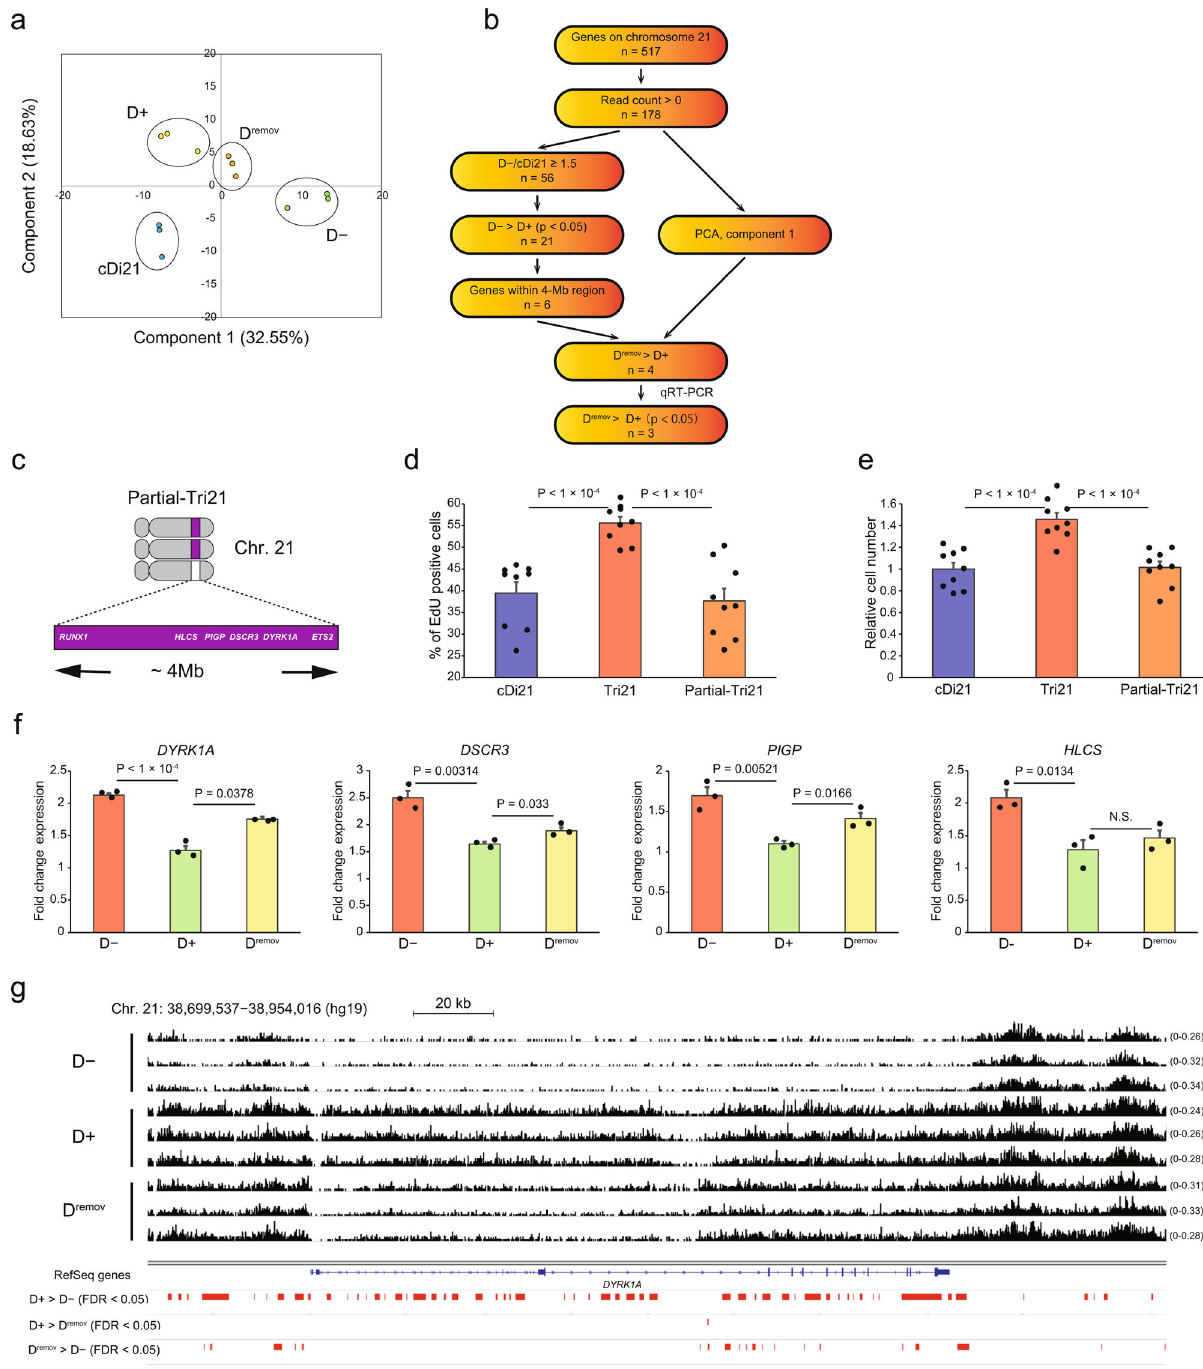
Fig. 4 Identi fi cation of candidate marker genes for the aberrant proliferation of DS APCs using PCA and Partial-Tri21 cell line. a Two-dimensional PCA of the expression pro fi les of 178 genes with positive read counts on chromosome 21 ( n = 3 per cell line). Note that the values of the D remov cell lines in component 1 were relatively close to those of the D − cell lines. b Scheme for identifying genes responsible for APC overproliferation using RNA-seq data and PCA. c Schematic illustration of chromosome 21 in the Partial-Tri21 cell line. The 4-Mb region between RUNX1 and ETS2 was deleted from a single copy of chromosome 21. d The percentage of EdU-positive APCs ( n = 3 independent differentiation experiments per cell line, each performed in triplicate). e Relative numbers of APCs 1 day after seeding. The cell numbers were normalised to that of the cDi21 cell lines ( n = 3 independent differentiation experiments per cell line, each performed in triplicate). f Relative expression levels of candidate genes involved in the overproliferation of DS APCs ( n = 3 experiments per cell line), normalised to that of cDi21 cell lines. g Map showing the distribution of H3K27me3 modi fi cations in DYRK1A in XIST -Tri21 APCs. Integrative Genomics Viewer screenshot (http://software.broadinstitute.org/software/igv/) of H3K27me3 ChIP-seq track peaks on DYRK1A (hg19) in D − , D + , and D remov lines. The Y -axis shows the number of fragments per base pair per million reads. (Red bars) The distributions of regions with signi fi cantly higher H3K27me3 accumulation in the indicated cell lines. Data were obtained from three lines ( d – g ). The error bars represent the SEM. The data shown were analysed using Student ’ s t -test ( d – f ). The FDR was calculated using the Benjamini – Hochberg method ( g ). NS not signi fi cant ( P > 0.05).